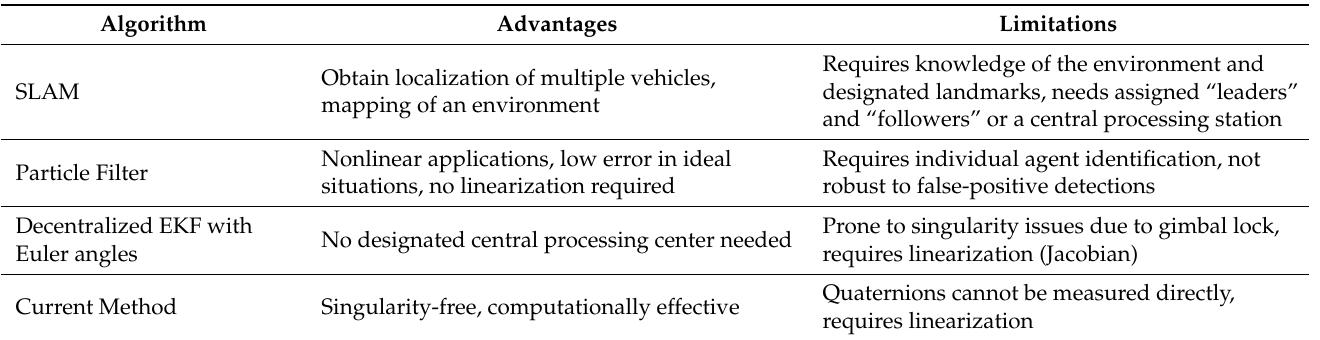
Table 1. Limitations of related